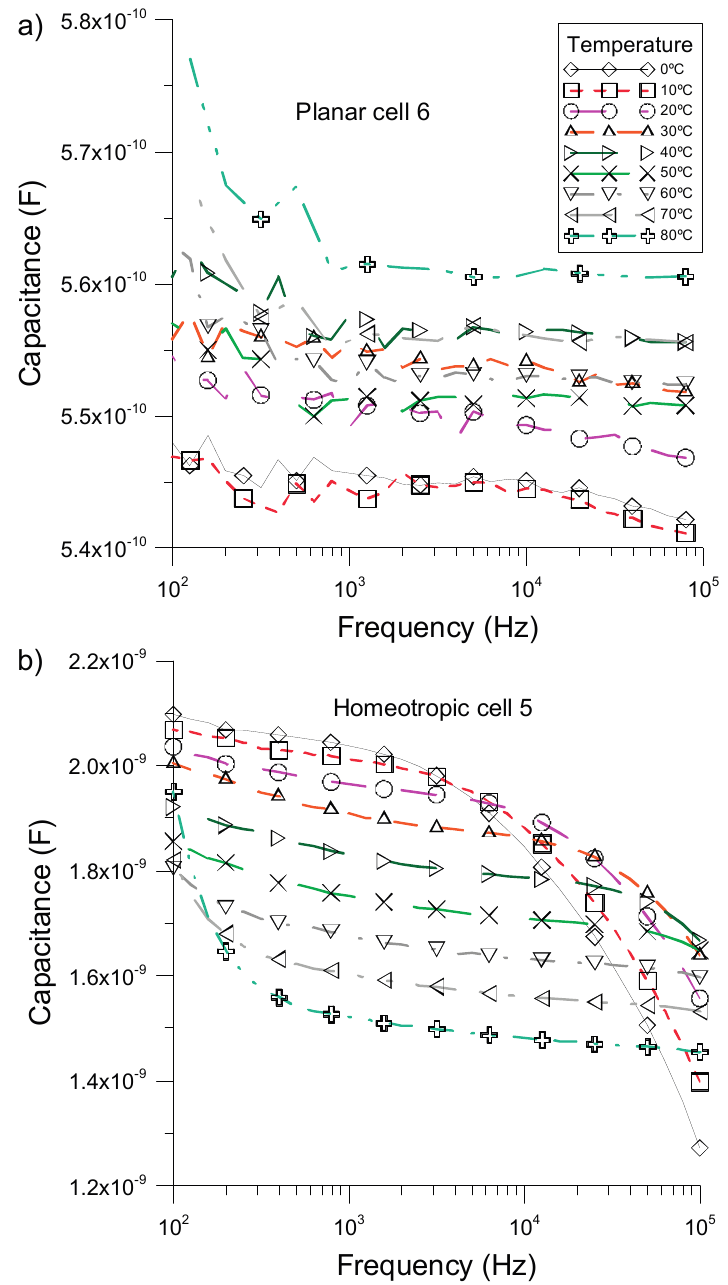
Figure 4. Variation of capacitance (C) as a function of the external frequency for different temperature values to ( a ) NLC cell 6 (planar cell) and ( b ) NLC cell 5 (homeotropic